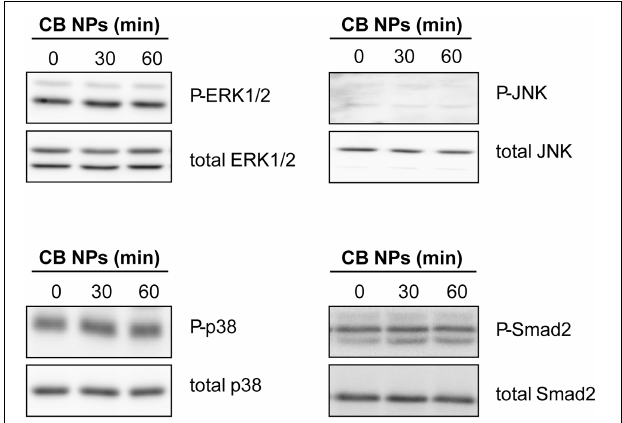
FIGURE 7 | Analysis of MAPK and Smad2 signaling pathways in L β T2 cells treated with CB NPs. L β T2 cells were cultured for the indicated times with 100 µ g/mL of CB NPs. Total and phosphorylated Erk1/2, p38, JNK and Smad2 were analyzed by immunoblotting as indicated in Materials and Methods. Seven independent experiments were performed and a representative immunoblot is shown for each protein.